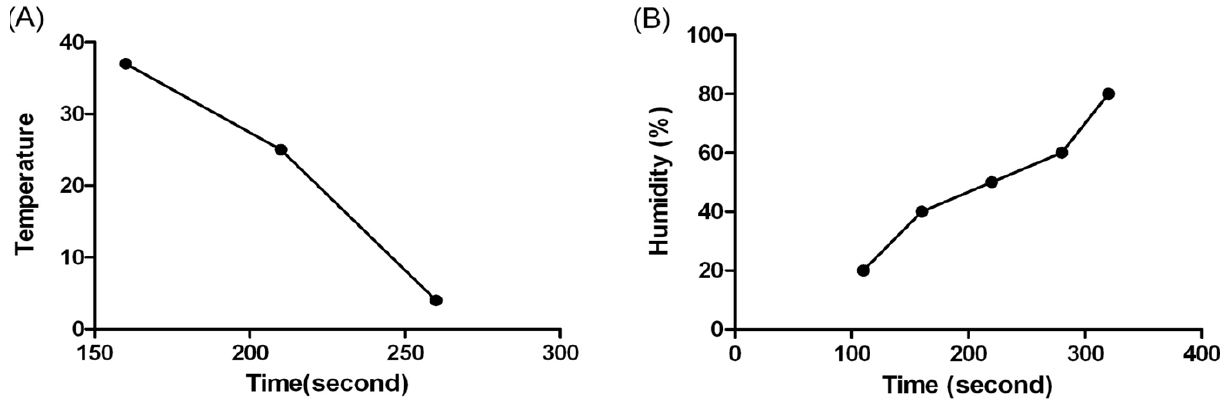
Figure 2. Optimization of QCM experiment conditions: ( A ) Reaction temperature dependent clotting time by QCM biosensor. ( B ) The effect of humidity on clotting